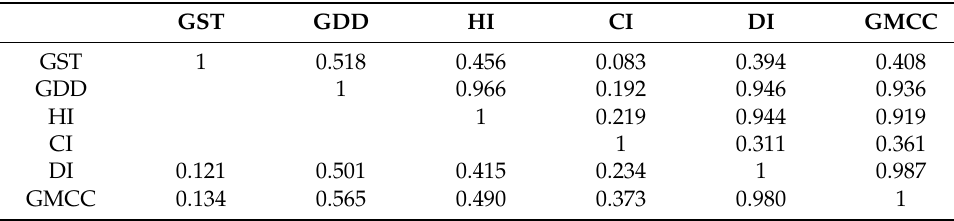
Table 6. Correlations among the Localized Constructed Analogs (LOCA) Coupled Model Inter- comparison Project phase 5 (CMIP5) [40,41] ensemble compositions and weights obtained using elastic-net regularization [33] to compute historic and future climate projections for the growing season average temperature (GST), growing degree days (GDD), Huglin index (HI), cool night index (CI), dryness index (DI), and the G é oviticulture multicriteria climate classification (GMCC) indices throughout the Willamette Valley American Viticultural Area (AVA). Values above the main diagonal treated each individual processed observation equally. Values below the main diagonal were obtained by balancing each functional observation group defining the index to be seen of equal importance at the start of the